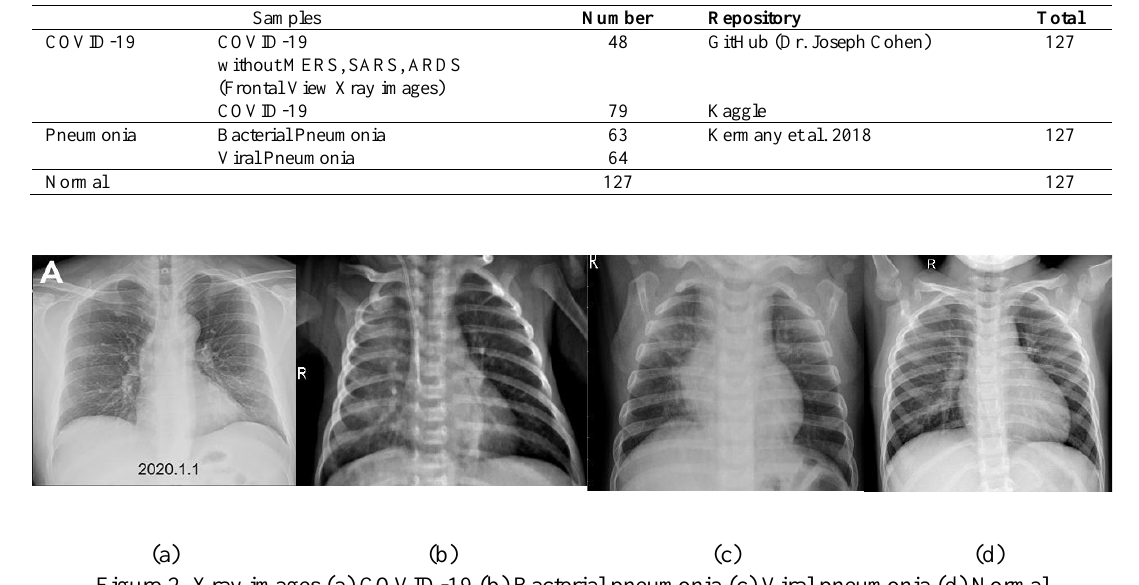
Figure 2. Xray images (a) COVID-19 (b) Bacterial pneumonia (c) Viral pneumonia (d)